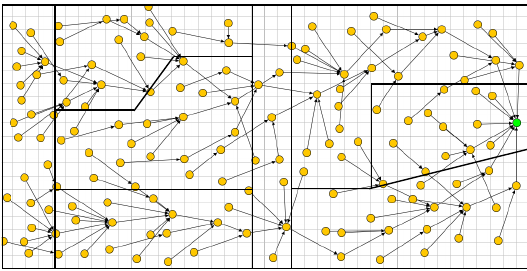
Figure 7. The DODAG built by RPL with 150